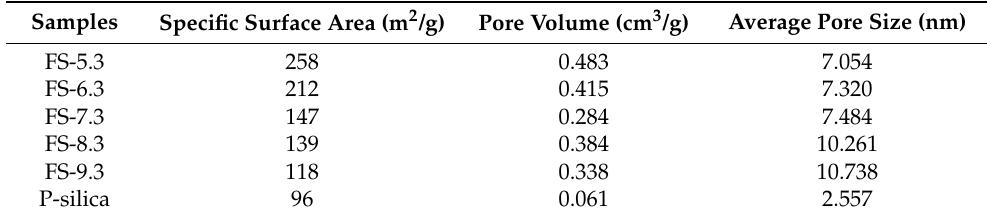
Figure 3. ( a ) N 2 adsorption/desorption isotherms of P-Silica and FS-SiO 2 . ( b ) Specific surface area, pore volume, and average pore size of P-silica and FS-SiO 2 . Table 1. The pore properties of P-silica and FS-SiO 2 .